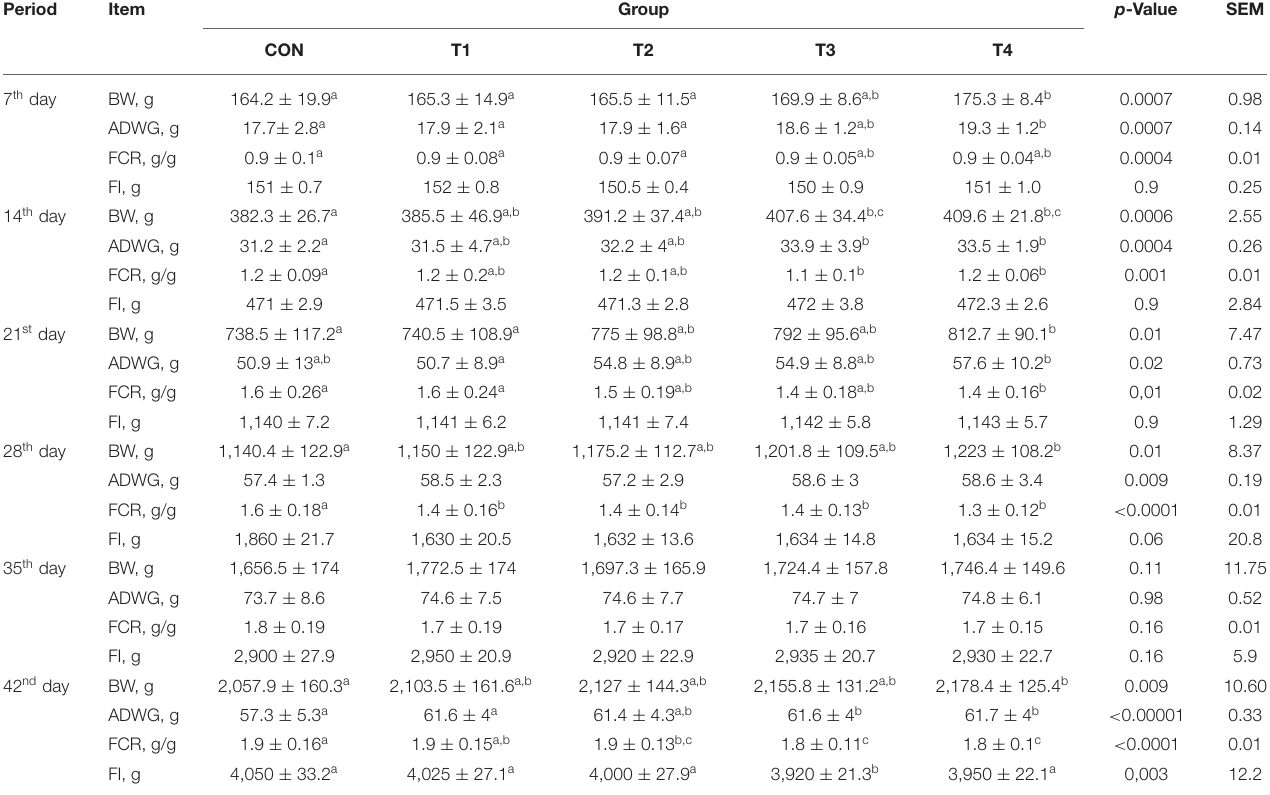
Means within the same row without common superscripts are significantly different (p <